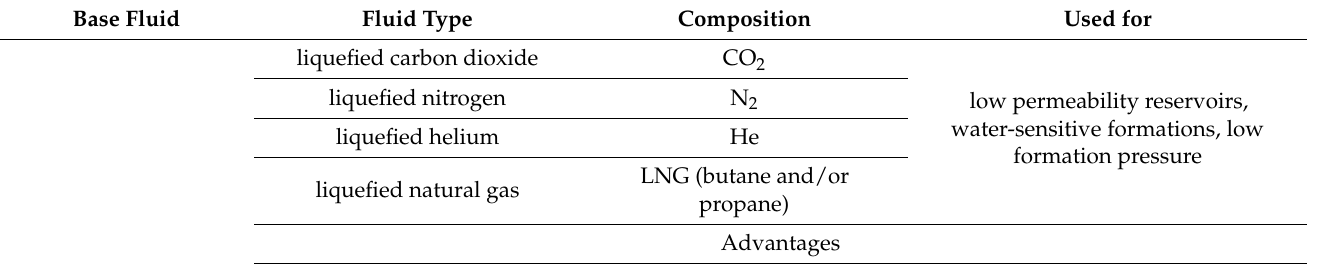
Table 10. Energized fracturing